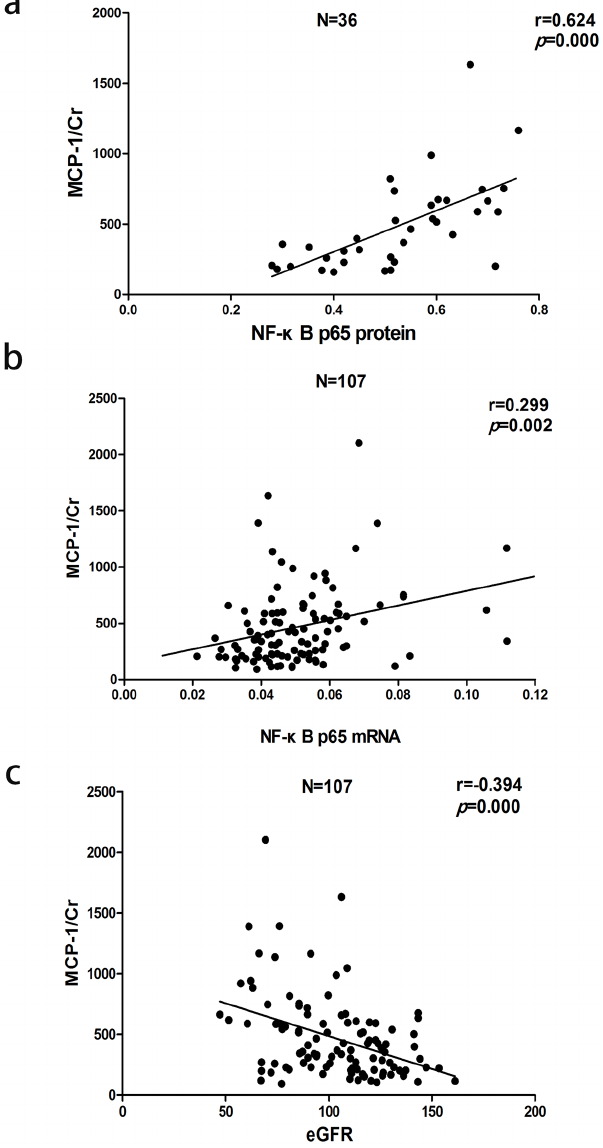
Figure 3. Excretion rates of urinary MCP-1 and RANTES. Note: Compared with NC group **: P , 0.01; compared with DN0 group ## : P , 0.01; compared with DN1 group gg : P , 0.01.